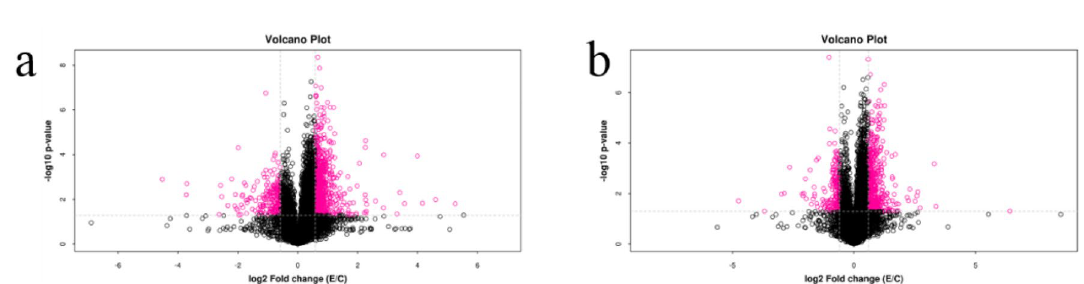
Figure 5. ( A ) 1 H-NMR based OPLS-DA score plot of subject serum samples; ( B ) 1 H-NMR based S-Plots of the OPLS-DA model from subject serum samples; ( C ) 1 H-NMR based OPLS-DA permutation test diagram of subject serum samples.